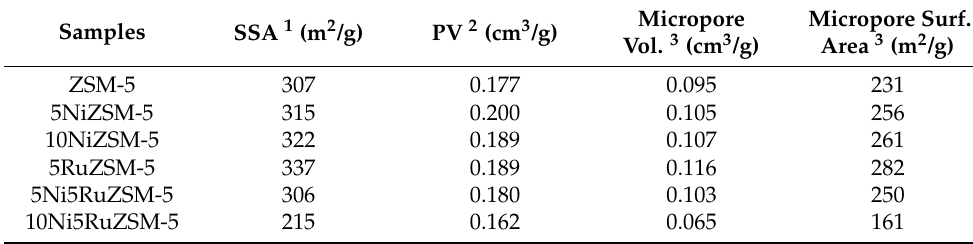
Table 2. Textural properties of the studied catalysts.